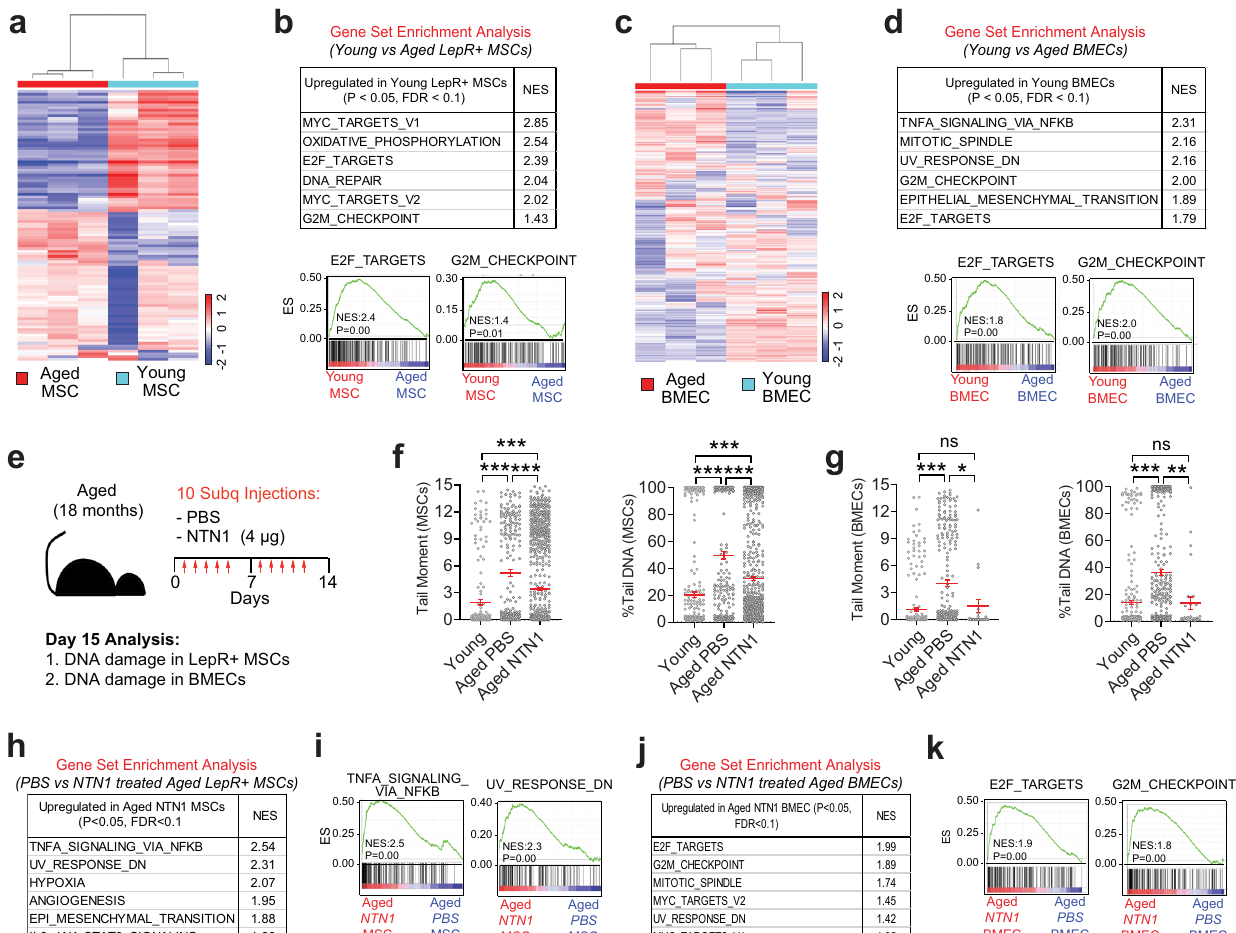
Fig.6|NTN1supplementationrestoresDNAdamagewithintheagedBMniche. a , b RNA-Seq analysis of LepR+ MSCs derived from young (3 month) and aged (18 month) mice. a Heatmap depicting hierarchical clustering of differentially expressed genes. b GSEA demonstrating downregulation of DDR pathways in LepR+ cells of aged mice. c , d RNA-Seq analysis of BMECs derived from young (3month) and aged(18month) mice. c Heatmapdepicting hierarchical clustering of differentially expressed genes. d GSEA demonstrating downregulation of DDR pathways in BMECs of aged mice. e Experimental design for NTN1 treatment. f , g Alkaline comet assays demonstrating an increase in average tail-moment and% Tail DNAinboth LepR+MSCs f , andBMECs g , ofagedmice ascomparedto